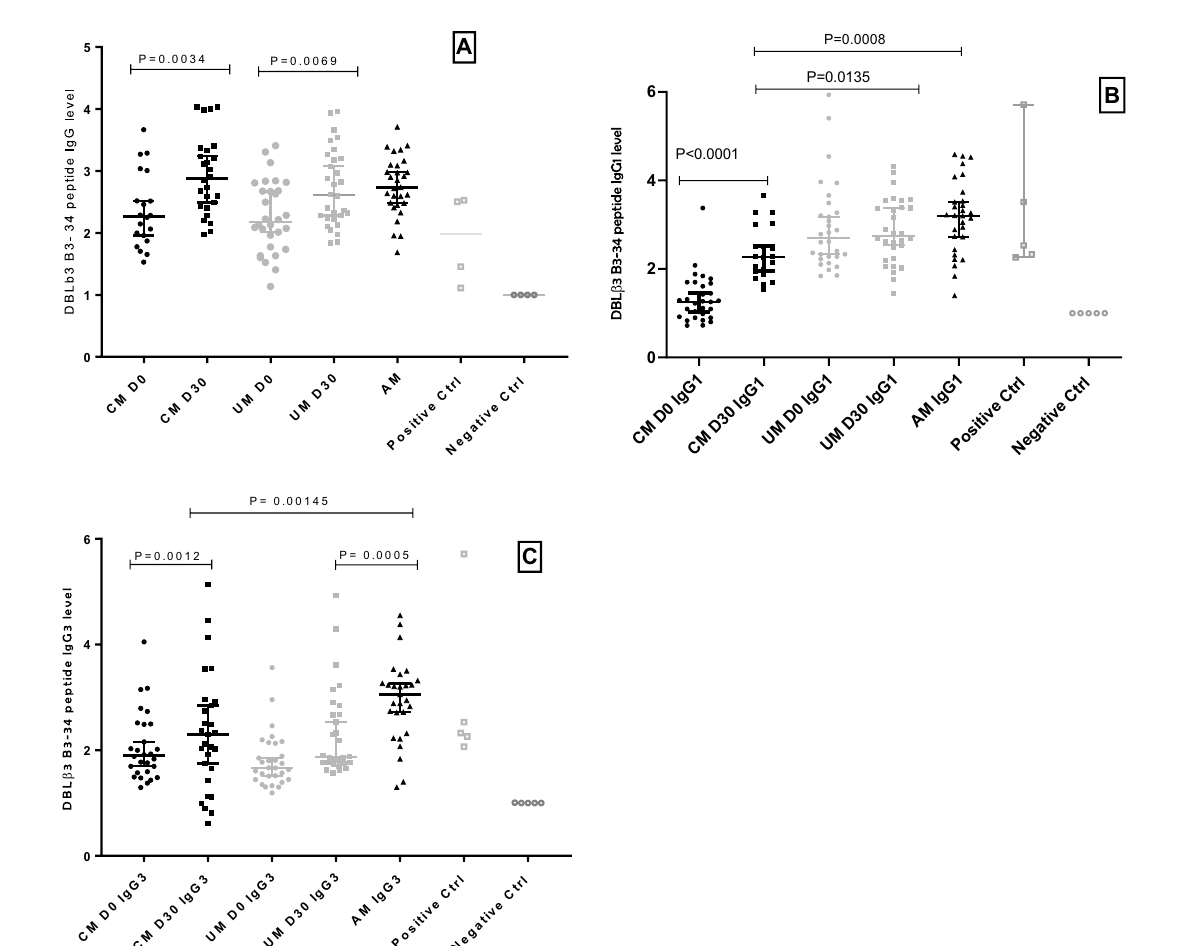
Figure 3. ( A ) IgG response against DBLβ3 B3-34 peptide in children with CM at Day 0 black circles at Day 30 black squares, in children with UM at Day 0 Grey circles and at Day 30 Grey squares. ( B ) and ( C ) is the IgG1 and IgG3 response against DBLβ3 B3-34 peptide in CM children Day 0 black circles, Day 30 black squares and UM children Day 0 Grey circles and Day 30 Grey